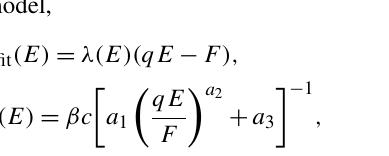
Figure 6. Mean electron energies at self-similar state (for distance record) for different electric field magnitudes. The data points are fitted with the model presented in Sect. 4.3.1 (Eq. 20). The values of the fitted parameters are presented in Table 2. To highlight the importance of including step limitations, Geant4 O1 values are pre- sented for two different max step ( δ(cid:96) max ) settings: one that is not acceptable (1cm) and one that is acceptable (1mm). The parameter α R is set to its default value of 0.8 for O1 and 0.2 for O4. model,